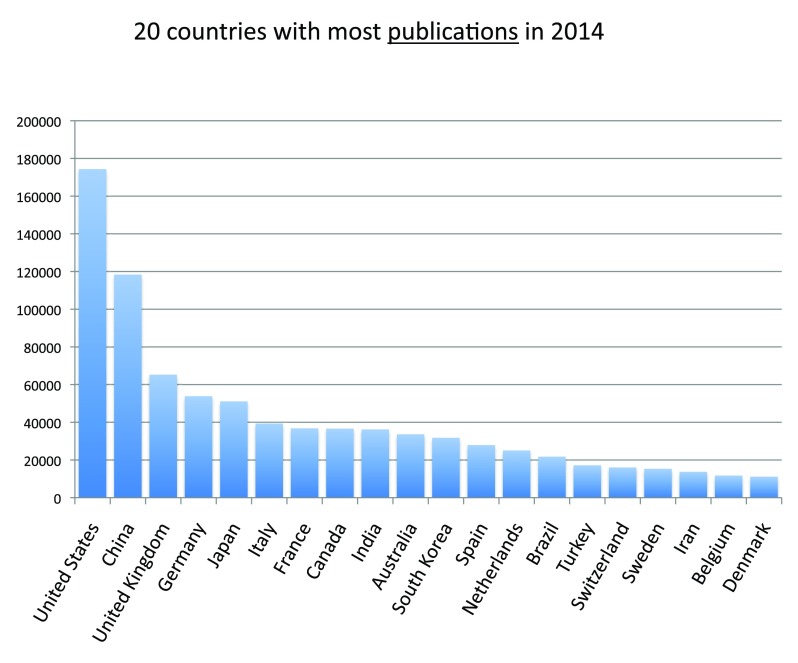
Numbers of publications (reviews excluded) of the 20 countries with the most publications (reviews excluded) in the year 2014.Criteria A. Note that starting from 2014 PubMed reports affiliation information not only of the first author (see Methods and Discussion sections for a correct interpretation of 2014 counts).